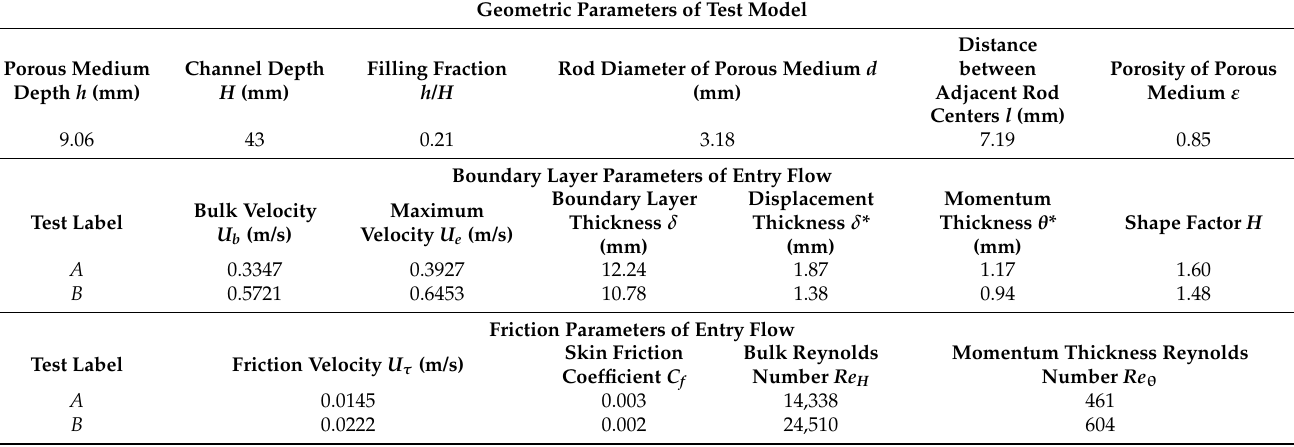
Table 1. Summary of geometric parameters of test model, boundary layer parameters of entry flow, and friction parameters of entry